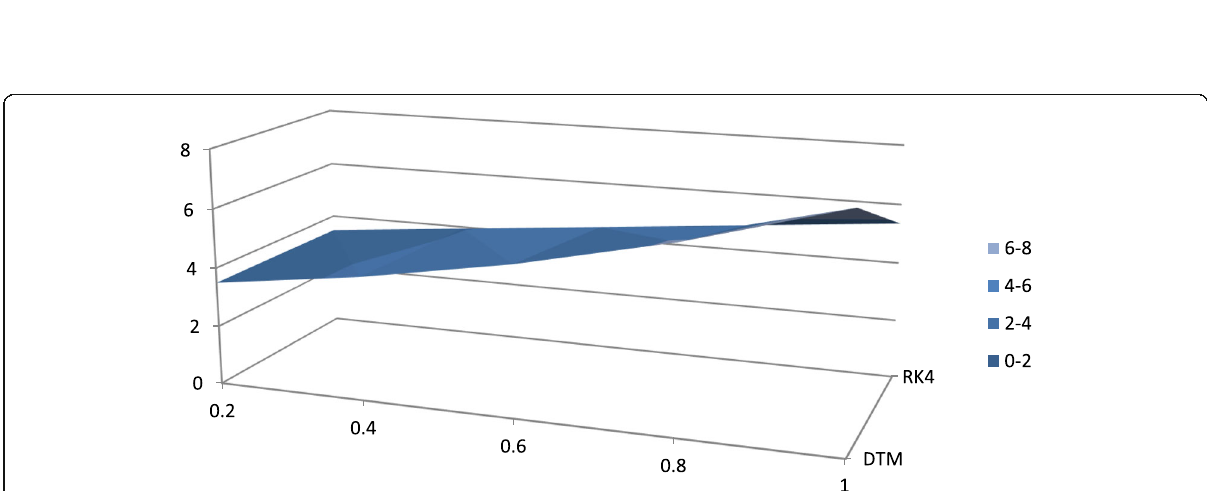
Fig. 15 Depiction of the behavior of sub-population of infected individuals who attend or are compliant to medical awareness program